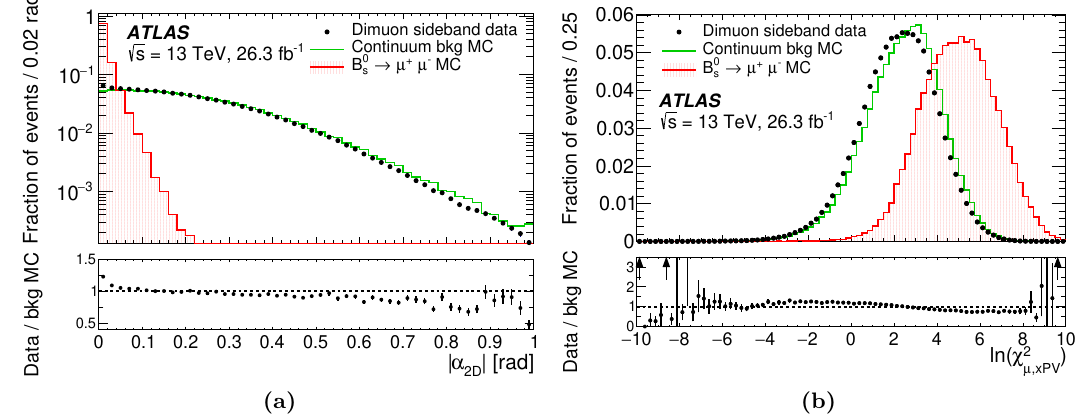
(cid:0) (cid:1) (cid:31) 2 (cid:22); xPV variables